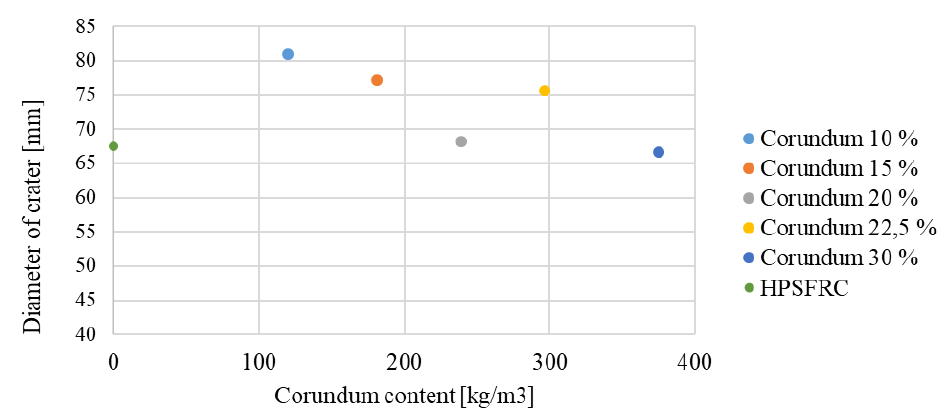
Figure 6. Dependence of crater diameter on corundum